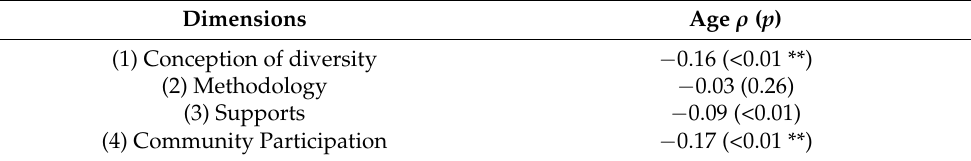
Table 4. Correlations between the dimensions and the age group